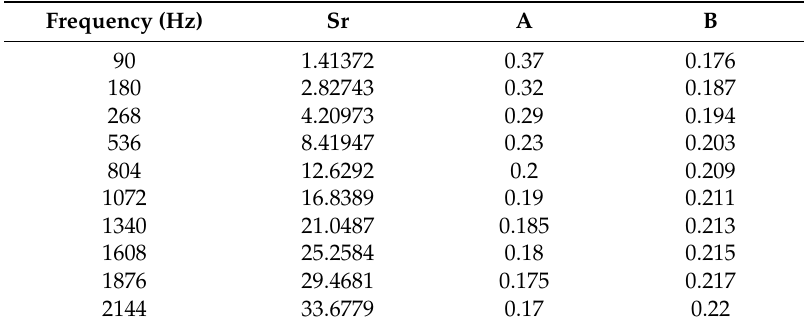
Figure 10. The values of C and D up to 2144 Hz in Equation (8) as a function of frequency obtained from extrapolation. Table 5. The A and B values from 90 to 2144 Hz in Equations (5) and (7) as a function of frequency.